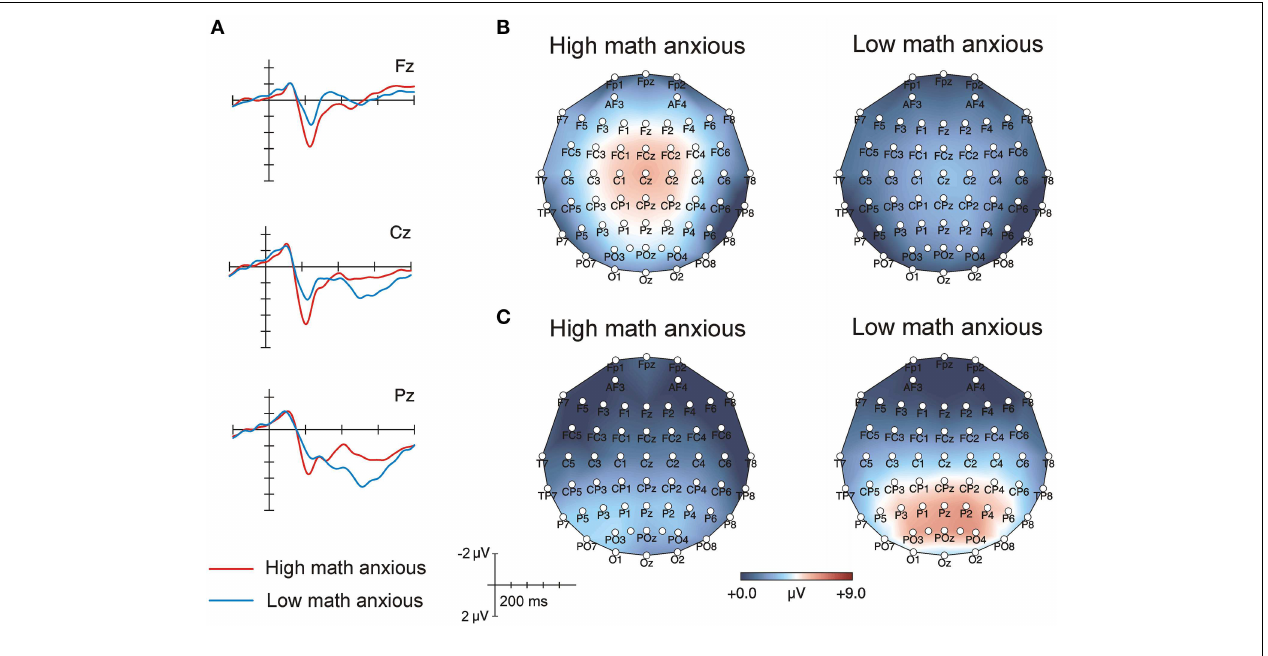
175–225ms window of the verification phase. (C) Topographic maps for HMA and LMA individuals in the 400–600ms window of the verification